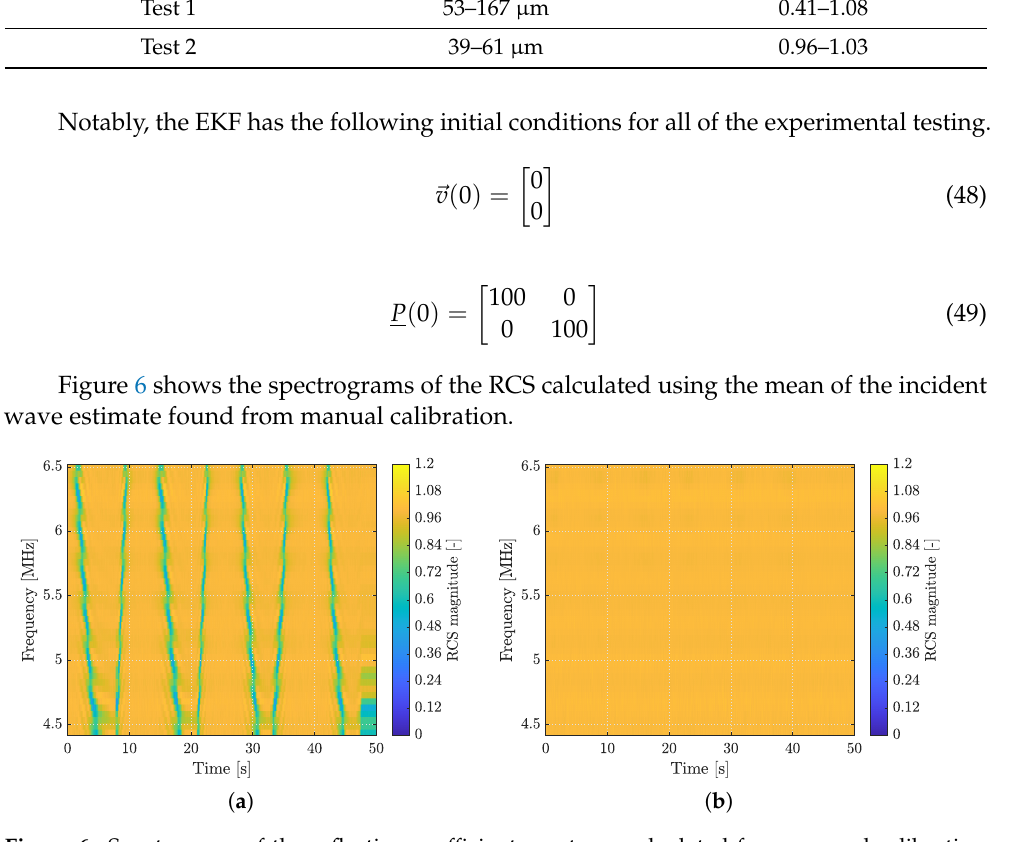
Figure 6. Spectrogram of the reflection coefficient spectrum calculated from manual calibration. ( a ) Test 1. ( b ) Test